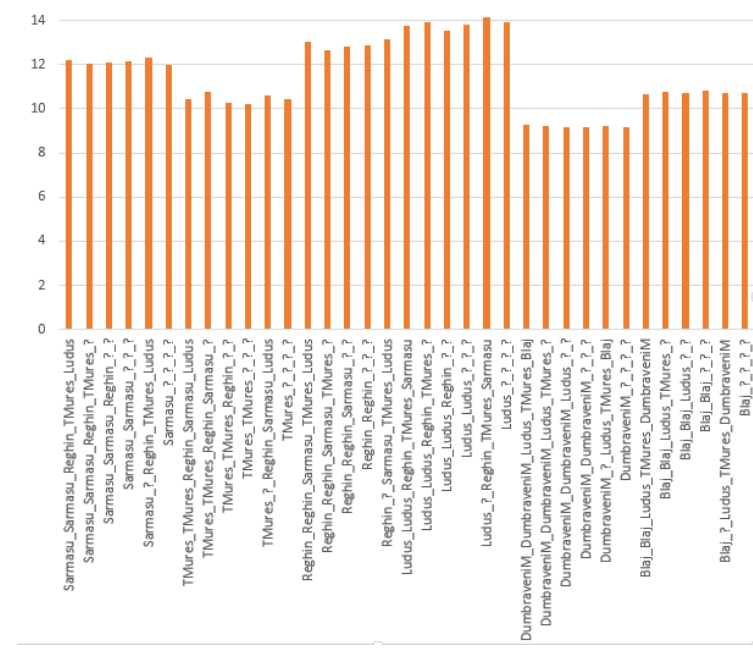
Figure 13. The RMSEs for k-NN algorithm with various setups: loc_context_colsrc1_colsrc2_colsrc3 ( X -axis) where loc is the location for which the prediction is run, context is the contextual data for that location, colsrc1 , colsrc2 and colsrc3 are the collaborative data sources, and the value of RMSE ( Y -axis); ? denotes missing data source.